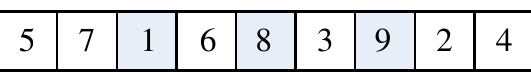
Fig. 3 The first gene position is not the source segment in the segment gene structure